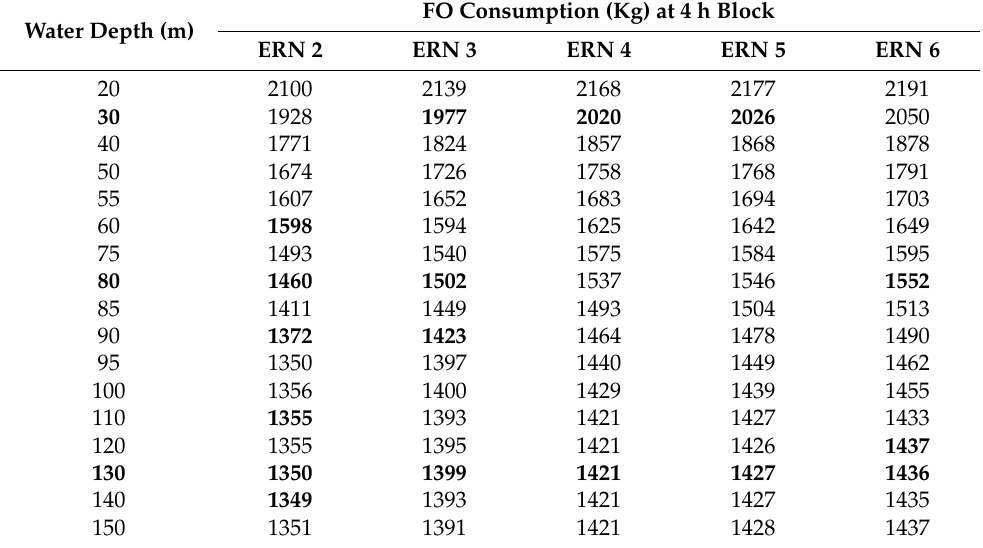
Table 3. FO consumption at various depth and ERN [for DP mode]. Water Depth